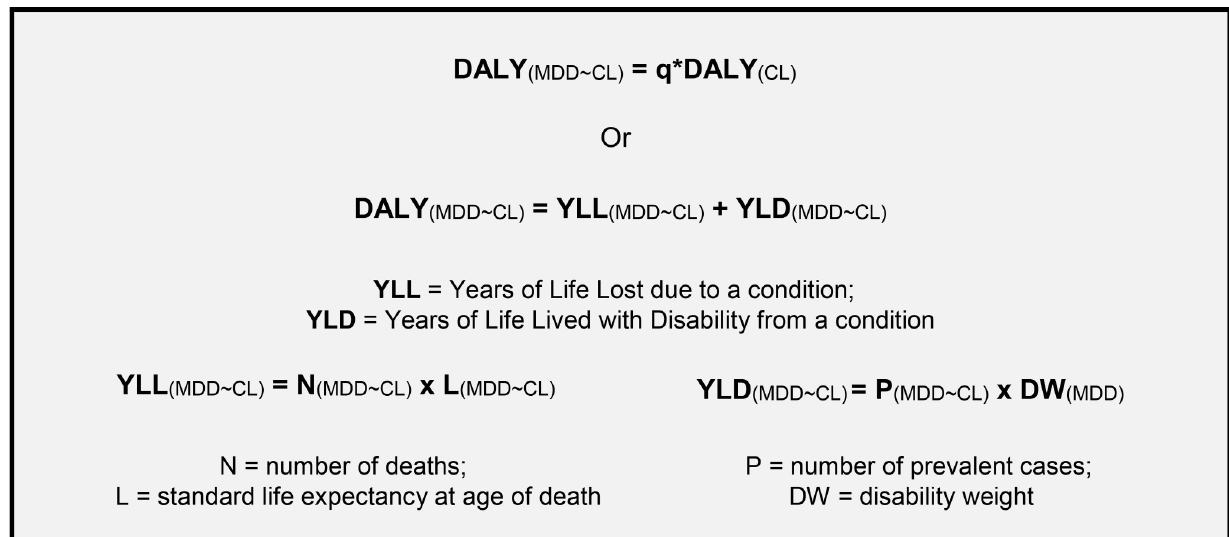
Fig 1. Modified disability-adjusted life years (DALY) model for calculating the burden of co-morbid conditions. Adapted from Ton et al (2015) [24].